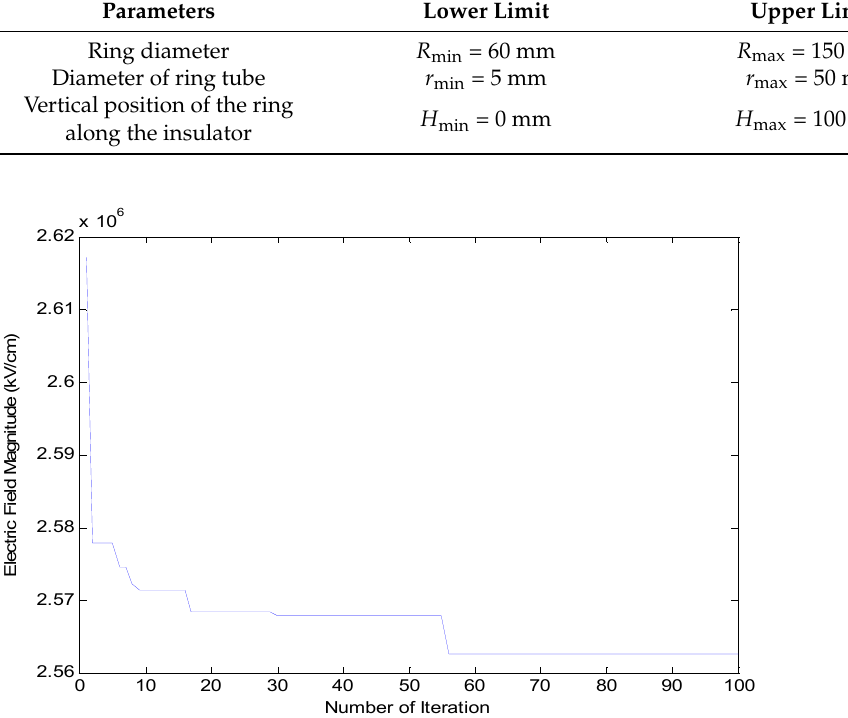
Figure 14. Simulation results for ICA after 100 iterations. In order to explain the mechanism of each of the optimisation methods, Figures 13 and 14 are referred to. The electric field magnitude is converging towards the minimum value against the iteration. For GWO, the process of searching begins with generating a random population of grey wolves, or the solutions of the candidates, which in this case are the diameter of the ring tube, ring diameter and vertical position of the ring along the insulator. The solution of every population, which is the electric field magnitude, is calcu- lated. At every iteration, the alpha, beta and delta wolves are estimating the possible po- sition of the prey. Every candidate updates its distance from their prey. The exploration and exploitation of the best solution are emphasised. The best solution is achieved when the distance between the wolves and their prey is converging. For the ICA, the process of searching begins with generating a random population of initial empires, which in this case are the diameter of the ring tube, the ring diameter and the vertical position of the ring along the insulator. The colonies are assimilated. At every iteration, any colony in an empire that has a lower cost or a lower electric field magnitude than the imperialist will exchange the position of the imperialist with the colony. The